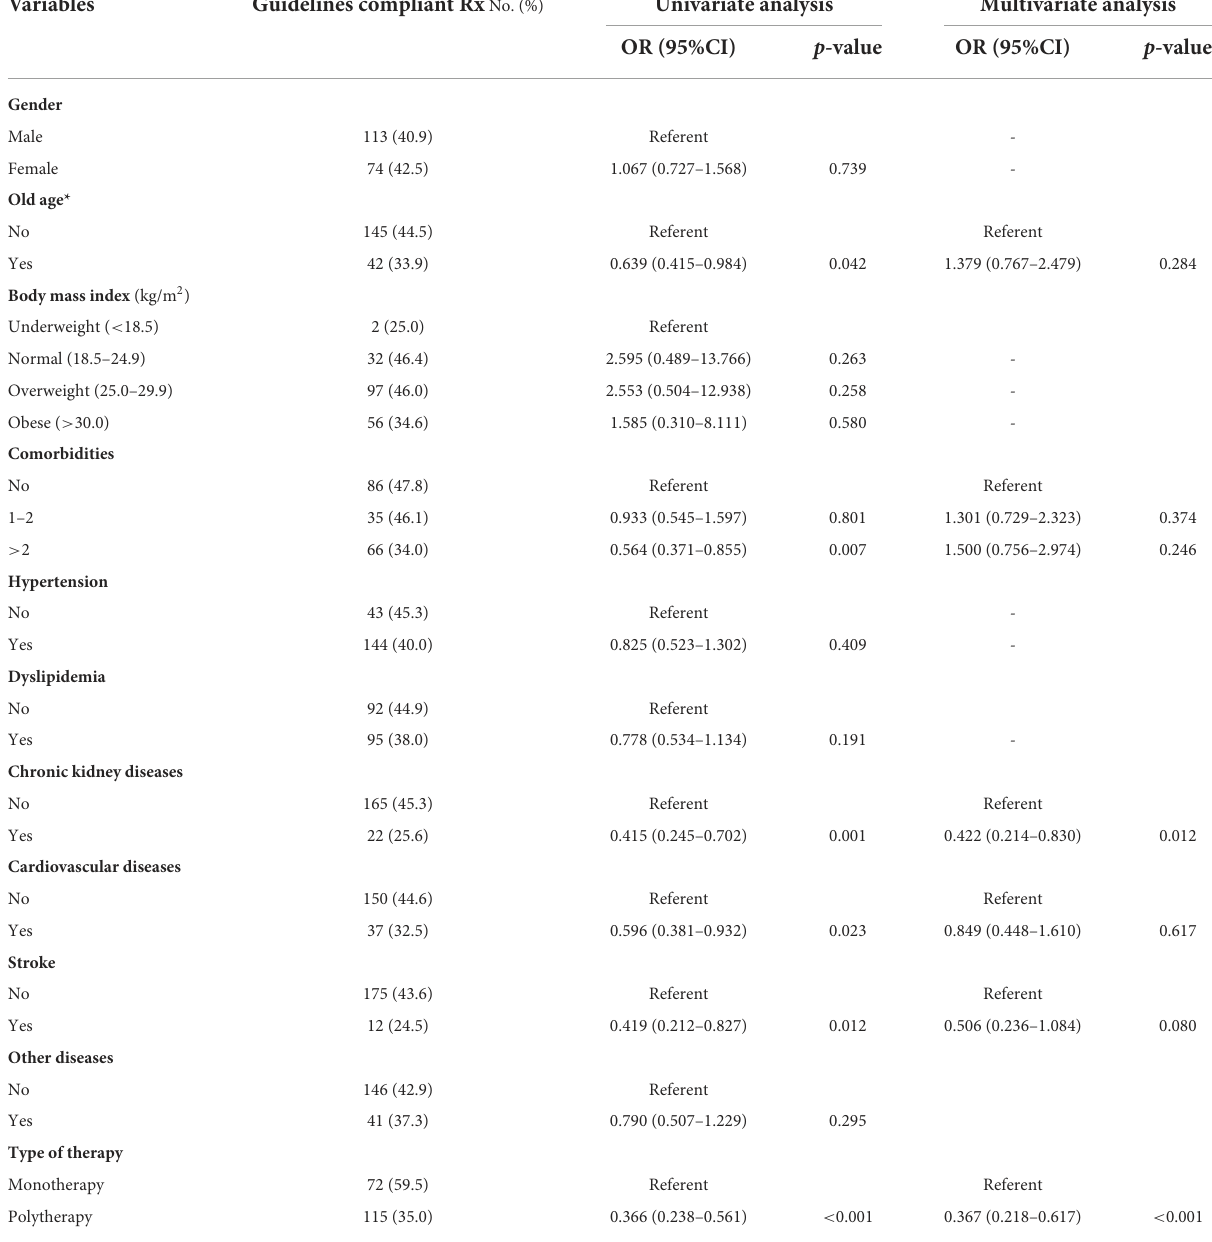
TABLE 4 Factors associated with receiving guidelines compliant